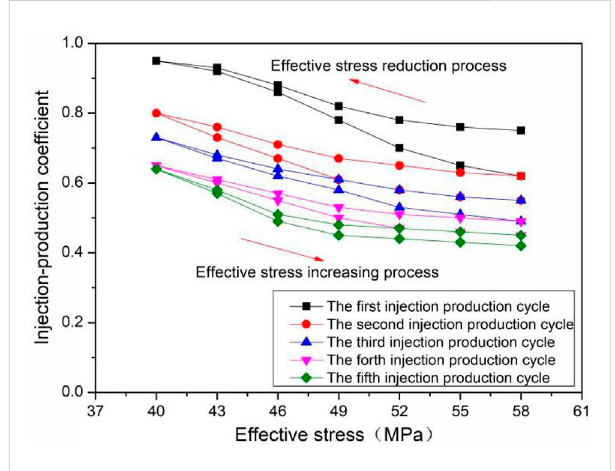
FIGURE 6 Injection-production coef fi cient changes with effective stress in different injection production